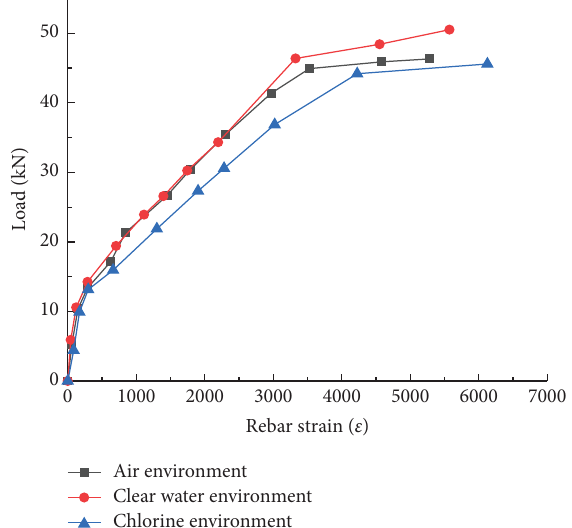
Figure 11: Strain-load curves of 20% graphite tailings concrete beams in diferent environments.